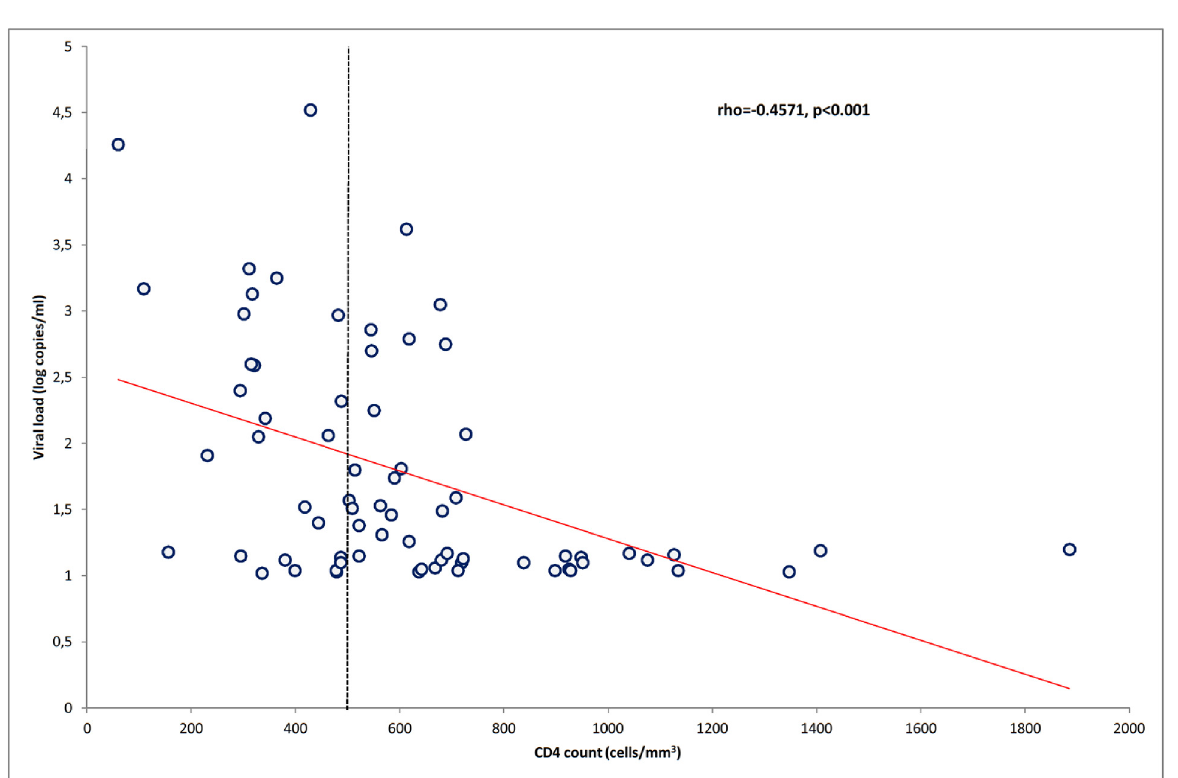
Fig 2. Correlation between plasma HIV-2 RNA and CD4 count among naive HIV-2 infected individuals in West Africa.